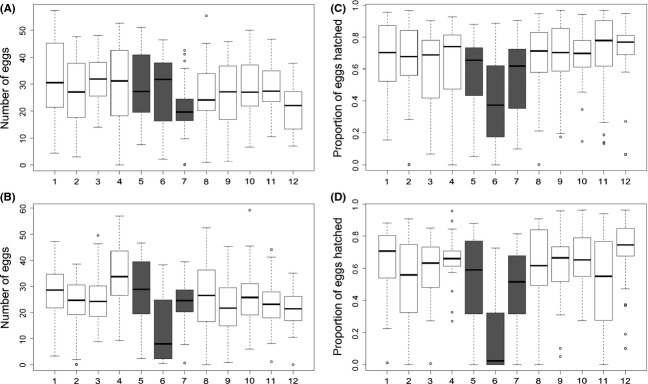
Egg counts of females mated with (A) American males and (B) Caribbean males. Hatchability of females mated with (C) American males and (D) Caribbean males. Each box plot is an isofemale line arranged from the northernmost location (left) to the southernmost location (right). Numbers on the X-axis correspond to those of Table1.